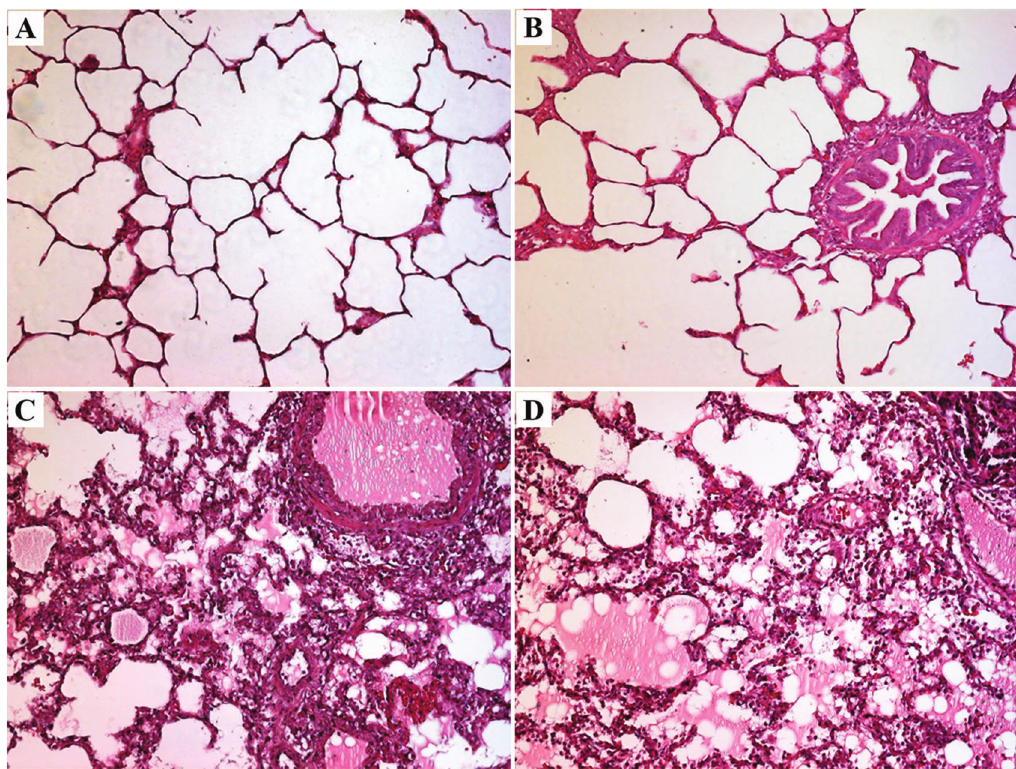
Figure 5 - Representative photomicrographs with hematoxylin and eosin (H&E) staining (x200) of the lungs of pigs submitted to acute lung injury. A) Sham group. B) hypertonic saline group. C) acute lung injury group. D) acute lung injury + hypertonic saline group. Extensive alveolar and interstitial inflammatory infiltration was seen in both injury